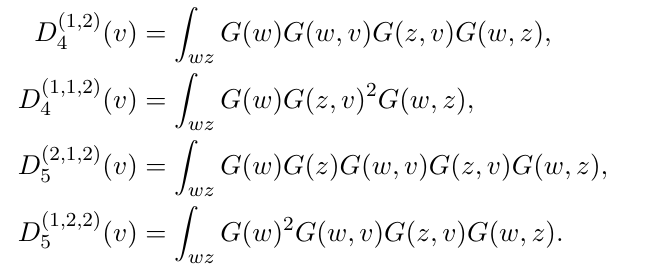
Figure 4 . (i) D 4 , (ii) C 1 , 1 , 2 , (iii) E 4 , (iv) D 3 , (v) E 3 , (vi) E 2